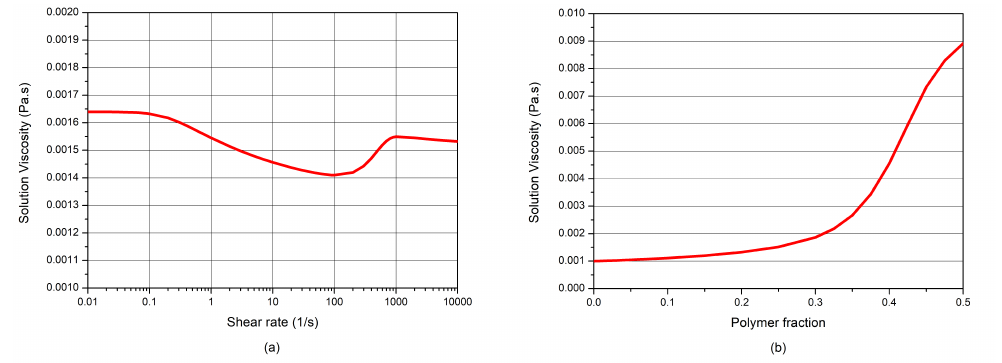
Figure 18. Polymer solution rheological behavior as a function of the shear rate ( a ), and viscosity as a function of the polymer concentration ( b